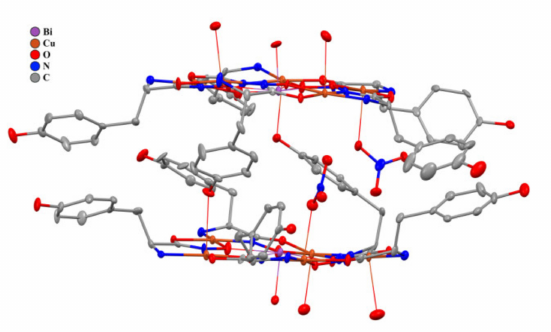
Figure 6. Side view of molecular structure of complex 1 . The thermal ellipsoids drawn are at the 30% probability level. All hydrogen atoms, uncoordinated NO 3 − , and solvate water molecules are omitted for